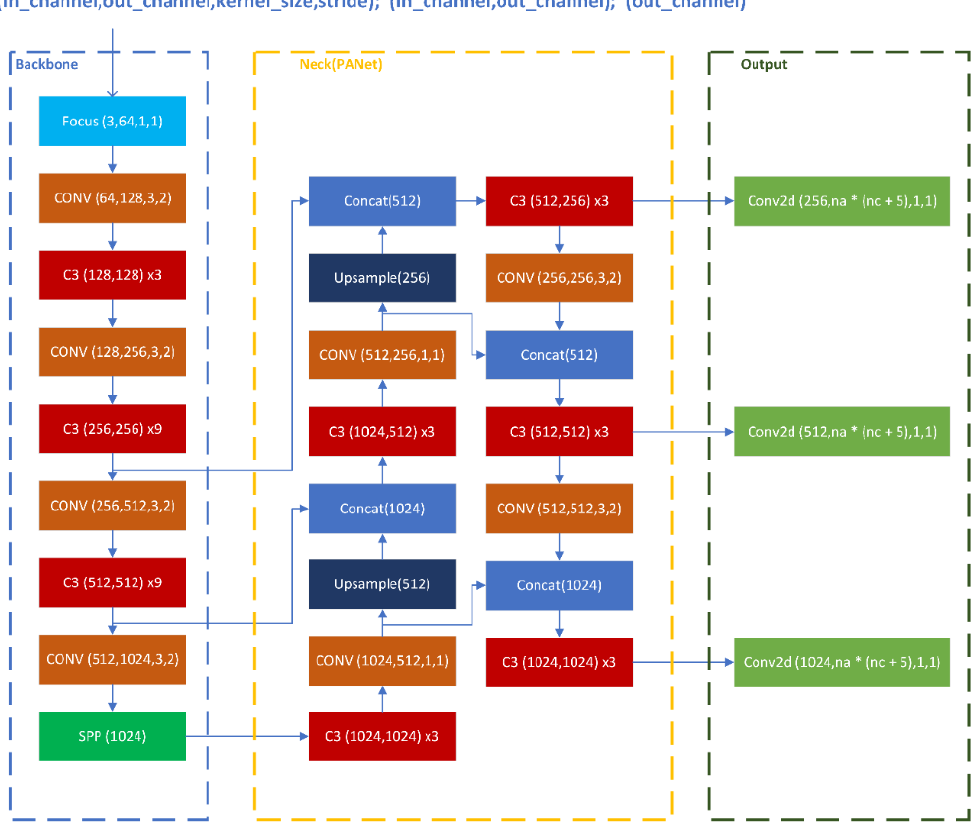
Figure 8. The network structure of YOLO v5. YOLO v5 has four network structure models: YOLO V5s, YOLO V5m, YOLO V5l, and YOLO V5x. Among them, YOLO V5’s network structure is the one with the smallest depth and the smallest width of the characteristic graph among the four network structures. YOLO V5m, YOLO V5l, and YOLO V5x all deepen the network’s structure and